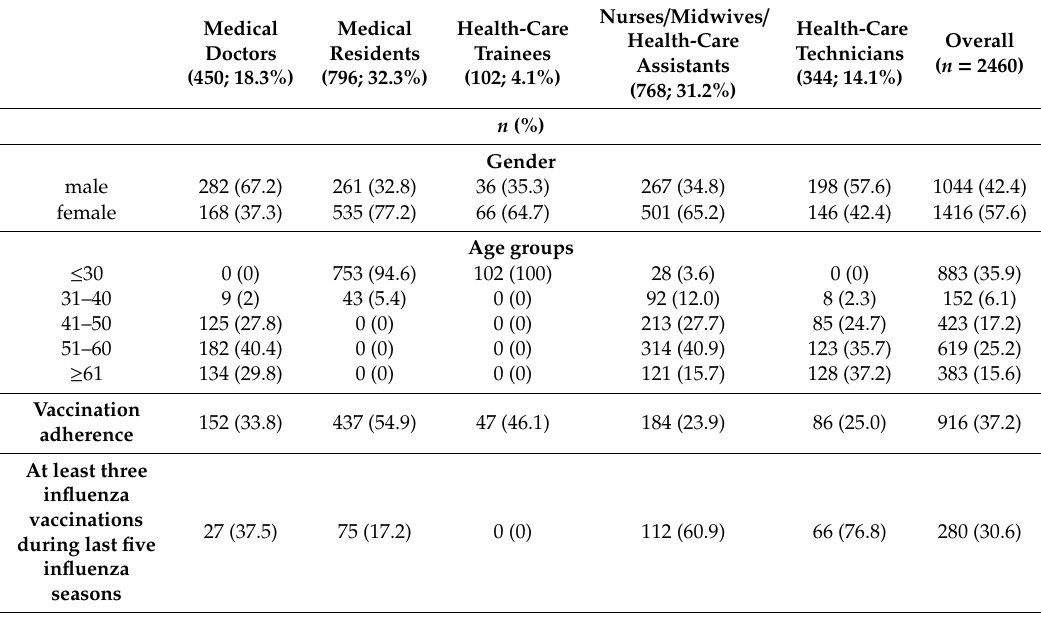
Table 2. Descriptive analysis of HCWs of the University Hospital (UH) of Palermo during the 2018/2019 influenza season.